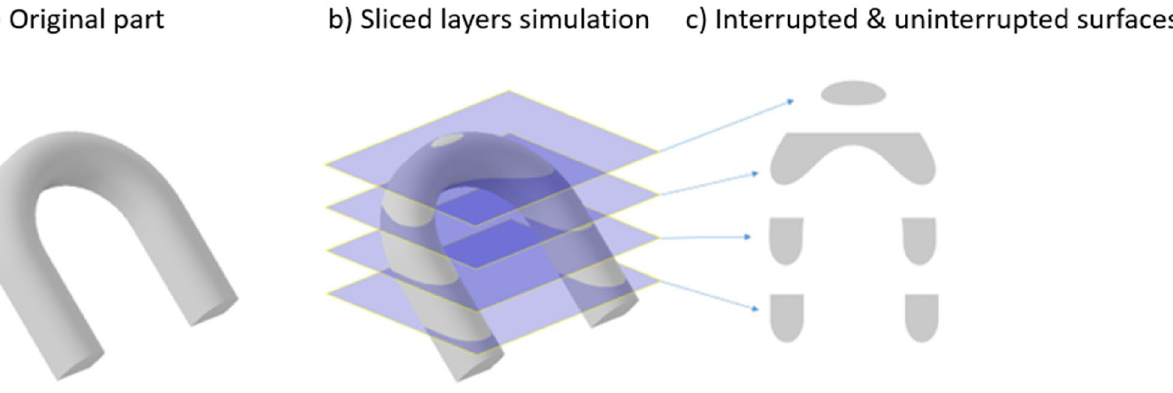
Figure 4. Representation of the meaning “uninterrupted surfaces” on the